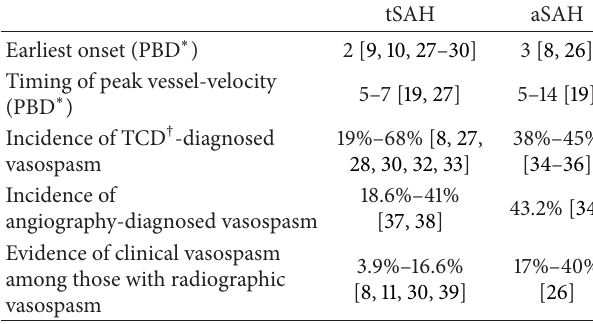
Table 1: Comparison of the epidemiology of traumatic subarach- noid hemorrhage (tSAH) to that of aneurysmal subarachnoid hemorrhage (aSAH). The shorter duration and lower incidence of clinical vasospasm highlight the less severe course of vasospasm following tSAH in comparison to